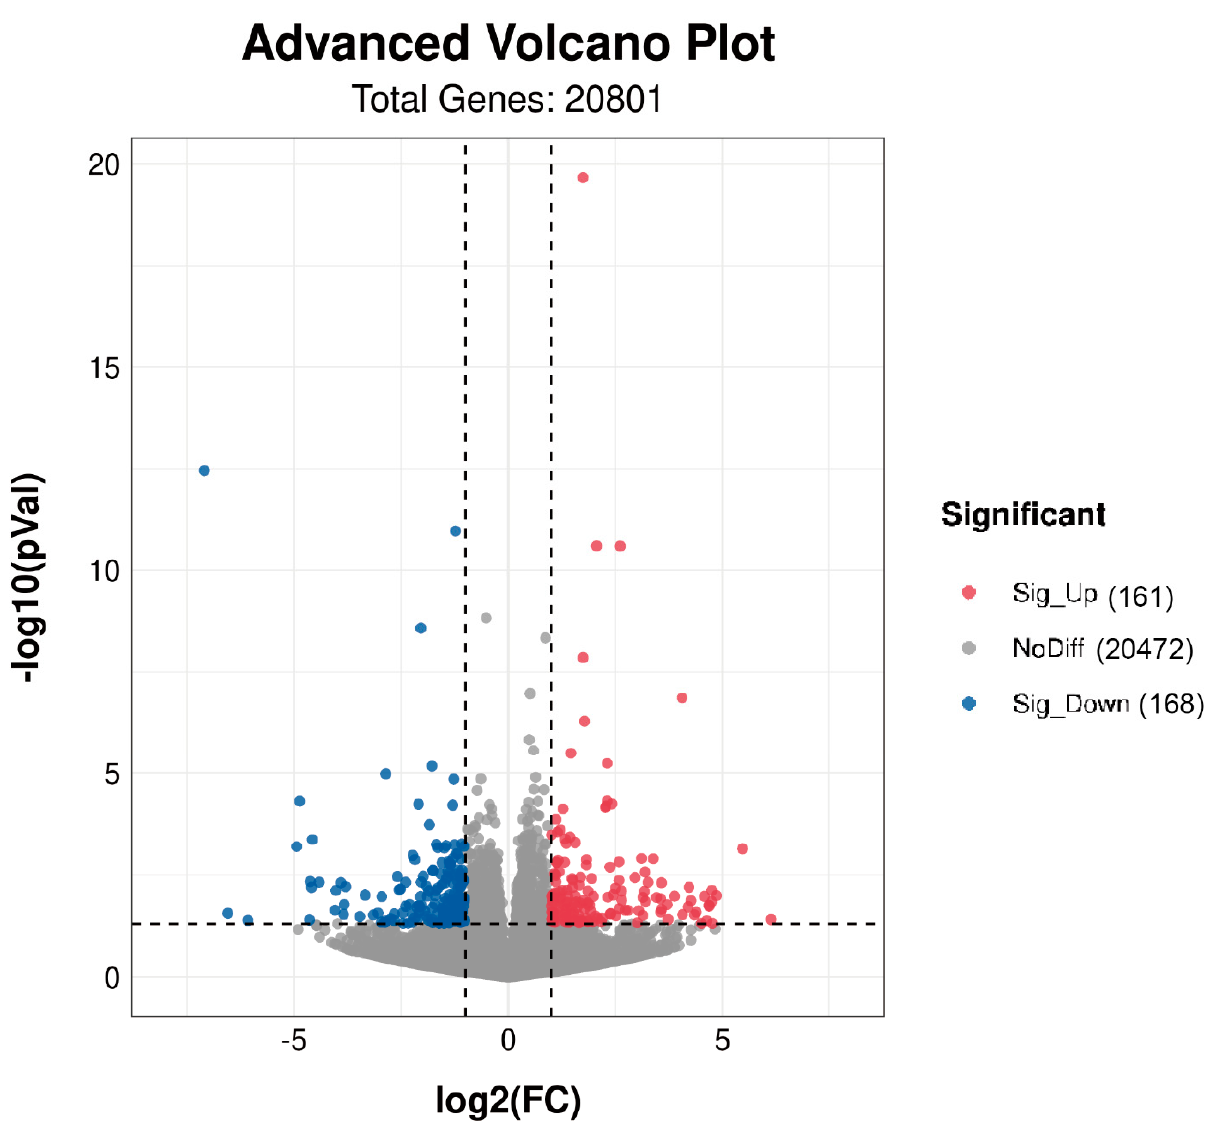
Figure 3. Volcano Plot of DEGs in longissimus dorsi muscle comparing H (high) group and L (low) group. The x-axis shows the values of log2 (fold change), while the average expression values of log10 ( p -Value) are displayed by the y-axis. The red and blue dots represent the significantly differentially expressed transcripts ( p -Value < 0.05) comparing the L group, with red for upregulated genes and blue for downregulated genes. The gray dots indicate the transcripts with expression levels which are not statistically significant ( p -Value > 0.05).